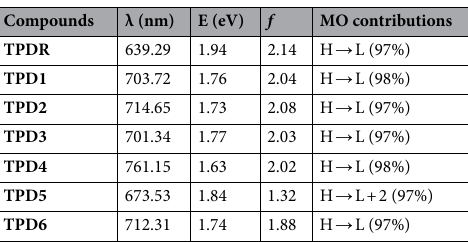
Figure 6. Simulated absorption spectra ( a ) in gaseous phase and ( b ) in chloroform of studied compounds. Compounds λ (nm) E (eV) f MO contributions